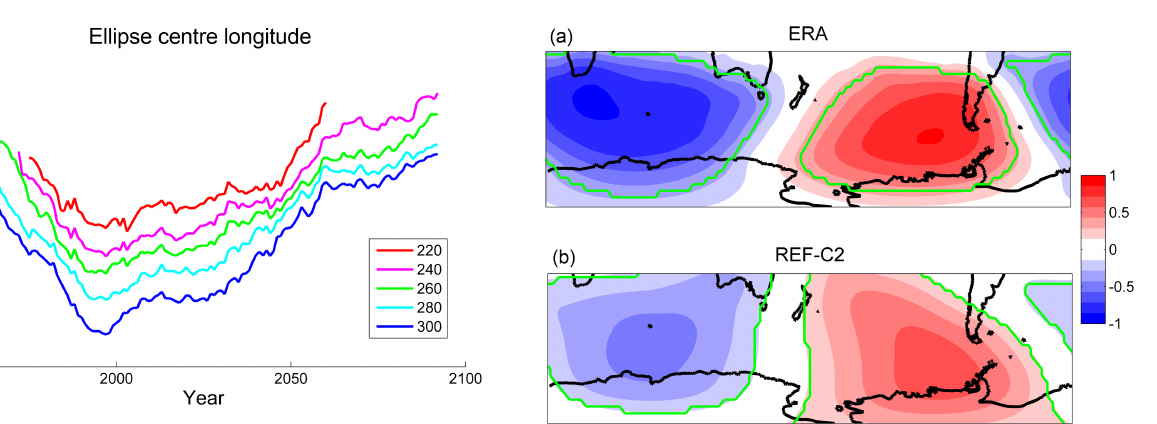
Figure 3. Time series of the ellipse centre longitude in the REF-C2 ensemble for different TCO contours. Figure 4. Correlation of October central longitude ellipse parameter